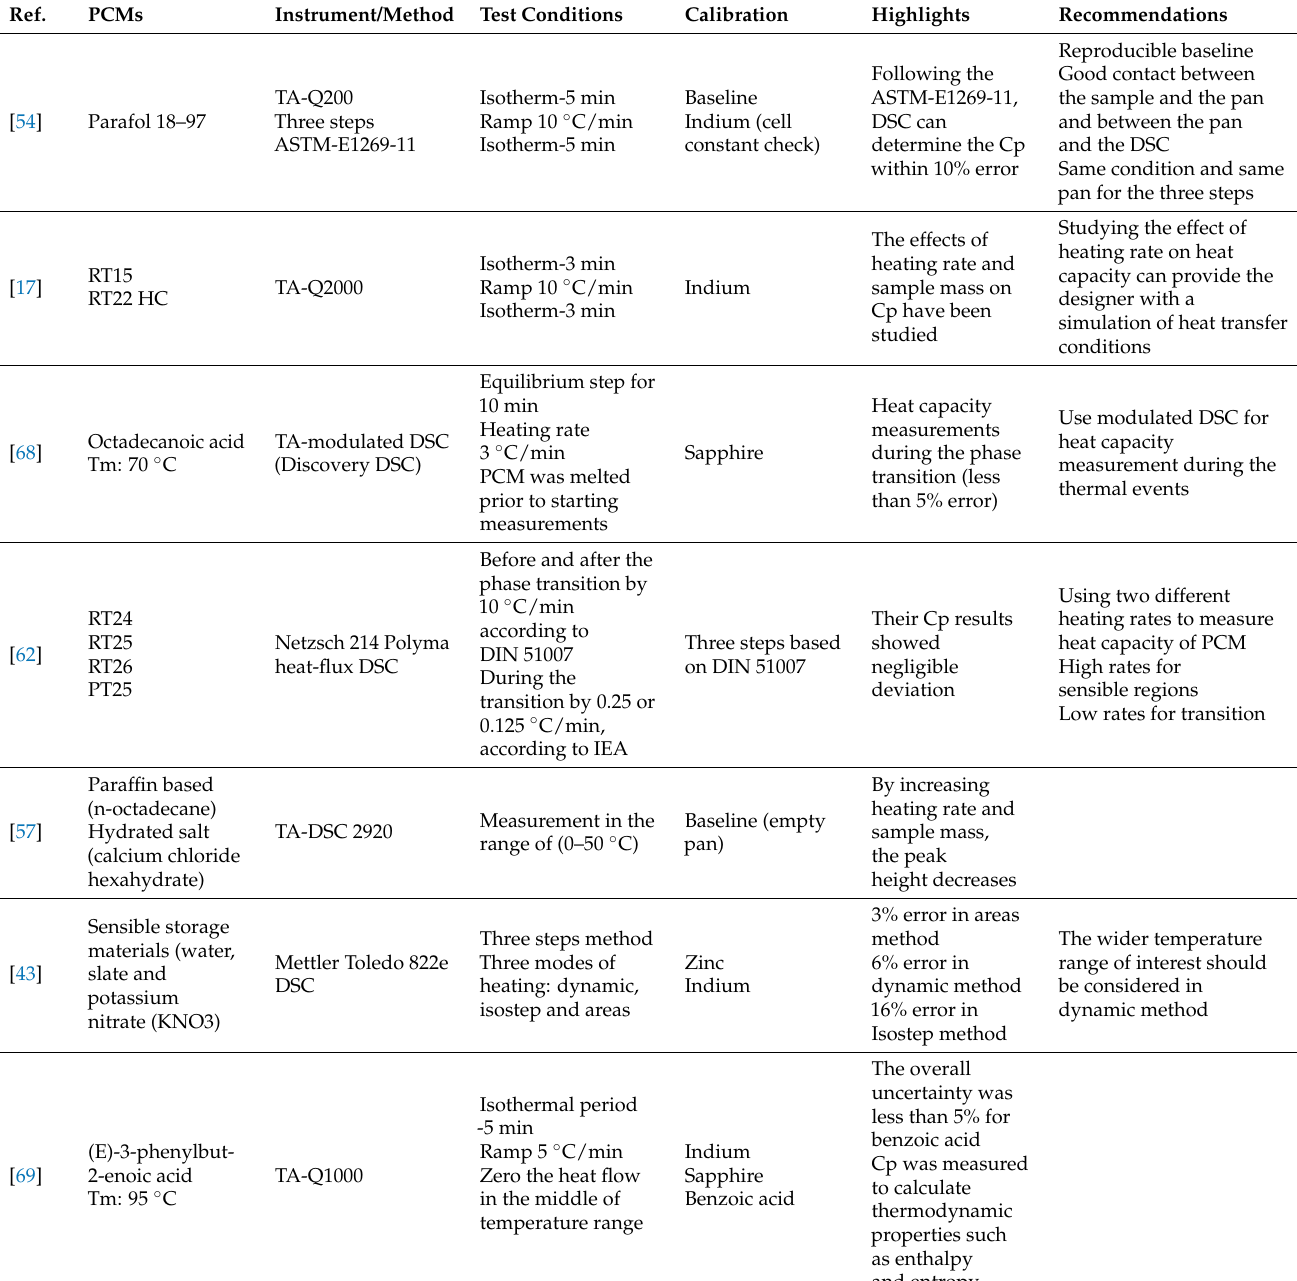
Table 9. Studies on C p measurements of